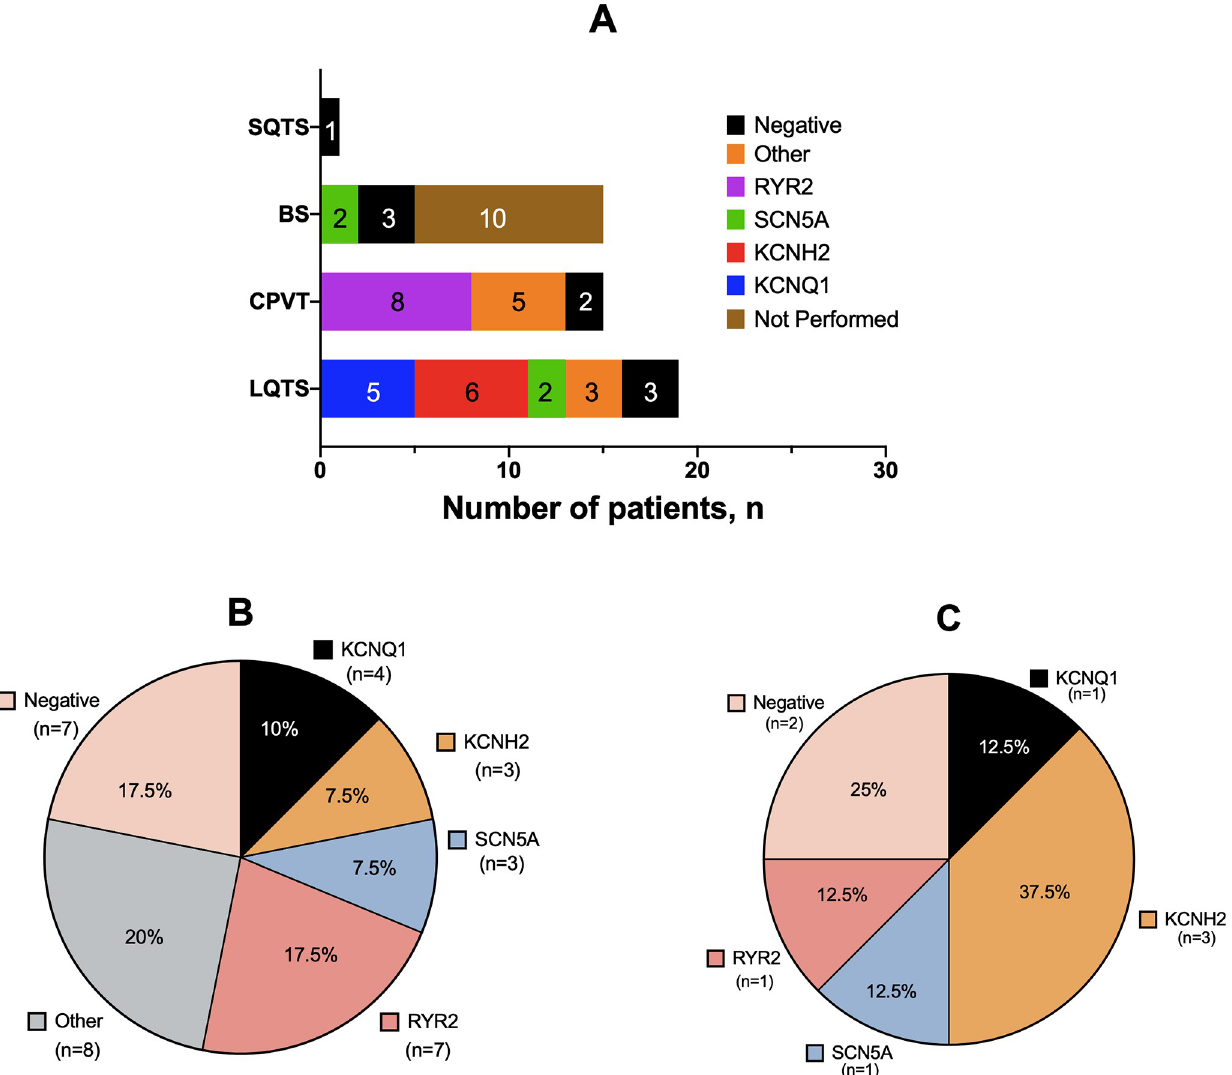
Fig 1. Primary inherited arrhythmic syndromes and genotype distribution among all probands (panel A), probands without previous epileptiform diagnosis (panel B) and probands previously misdiagnosed (panel C).